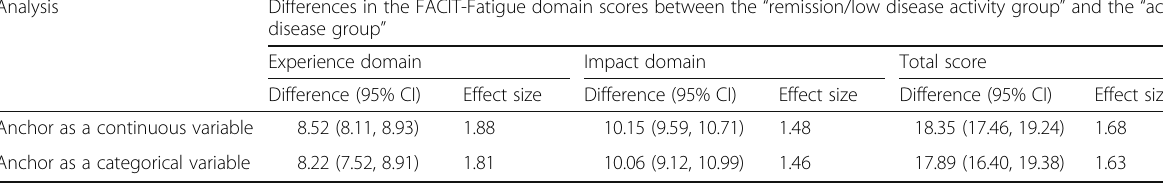
Table 5 Known-groups validity for FACIT-Fatigue in patients with PsA Analysis